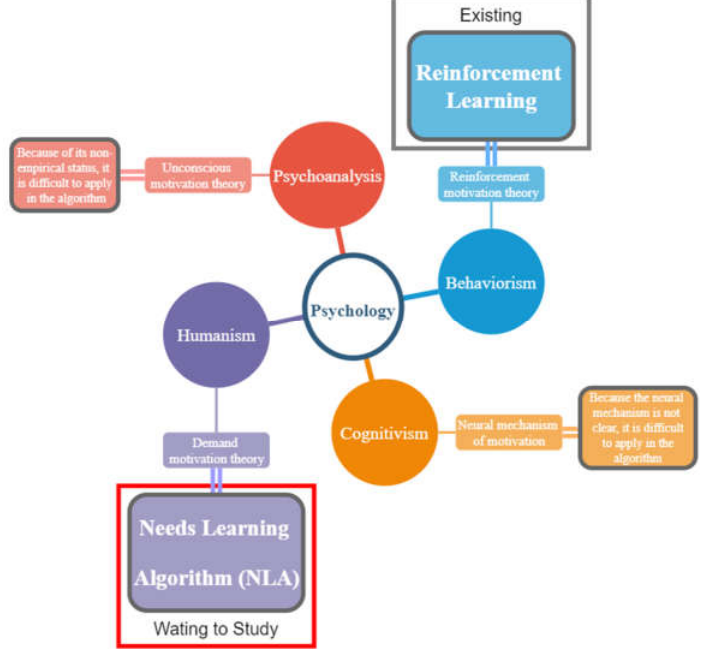
Figure 1. Motivational theoretical basis for the needs learning algorithm.